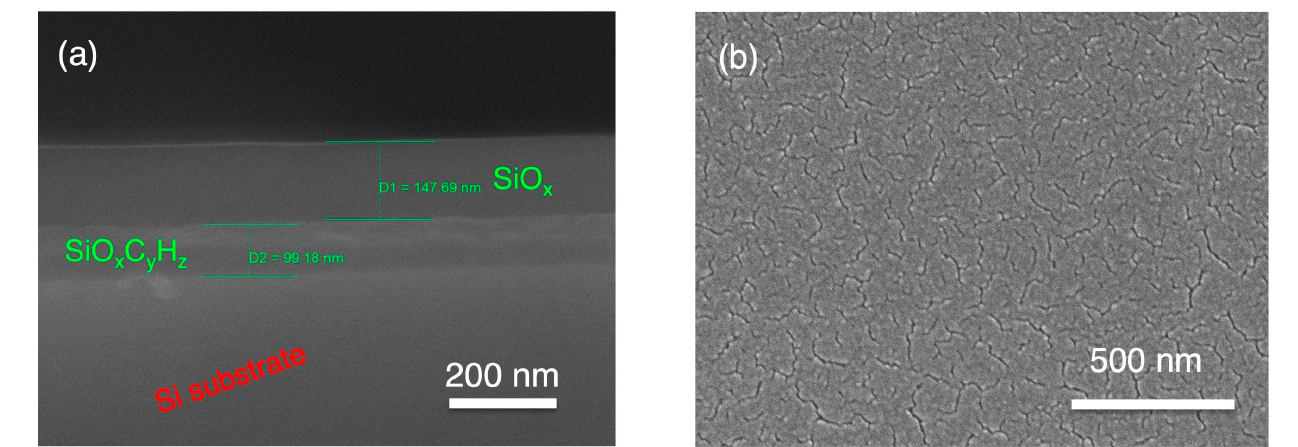
Figure 3. SEM cross-section of organic and inorganic layers on silicon ( a ) and top view of the de- posit ( b ).